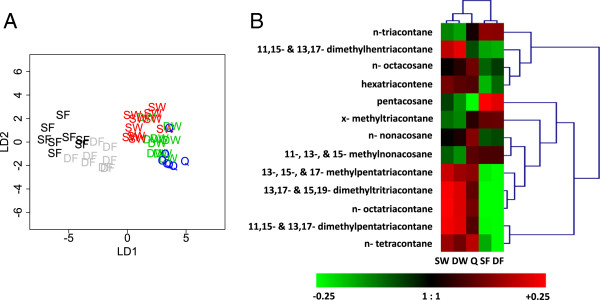
Multivariate analyses of cuticular hydrocarbon data. A) Linear discriminant analysis (LDA) of chemical profile data, showing graphs based on values of the two major linear discriminants, derived from quantities of compounds extracted from the cuticle from the five groups (DF = dominant foundress, SF = subordinate foundress, DW = dominant worker, SW = subordinate worker, Q = queen). B) Patterns of cuticular hydrocarbon abundance reveal a cluster of compounds related to season and/or social environment. Hierarchical clustering (represented by blue dendrograms) of mean values (log10 transformed) for 13 compounds with significant differences across the five female groups. The heatmap illustrates the fold difference in log10 levels of each compound compared to the overall mean for each compound (1:1), with higher levels in red and lower in green. Five compounds (bottom of the figure) show a similar pattern in which levels are lowest in foundresses and highest in workers and queens, reflecting differences in season and/or social environment.